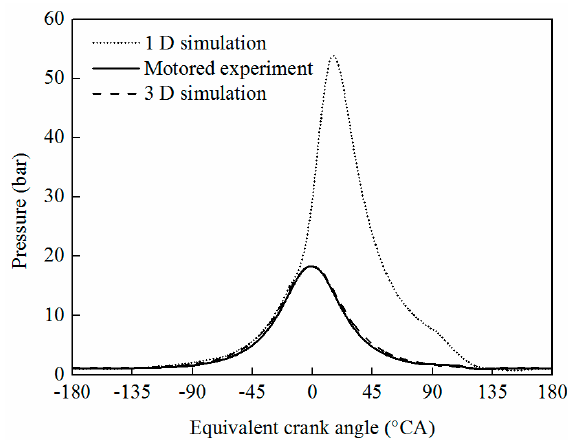
Figure 8. In-cylinder pressure comparison.